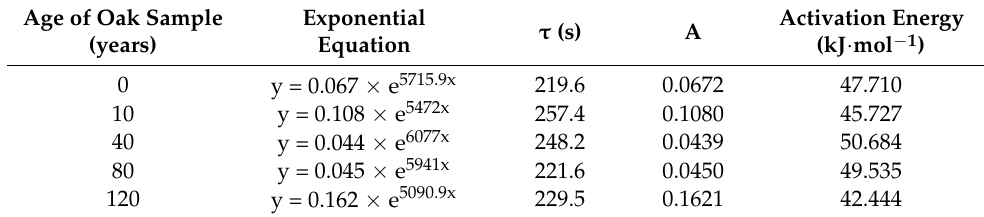
Table 5. The activation energy values of individual test